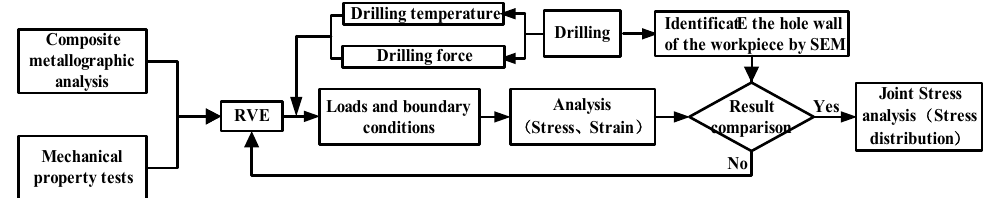
Figure 1. Flow chart of the method used to analyze microscopic thermodynamic characteristics.